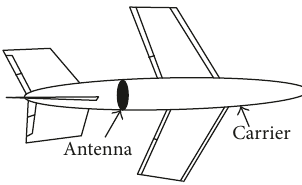
Figure 1: Cylindrical conformal antenna schematic diagram.